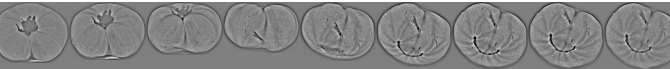
Figure 17. Result of image